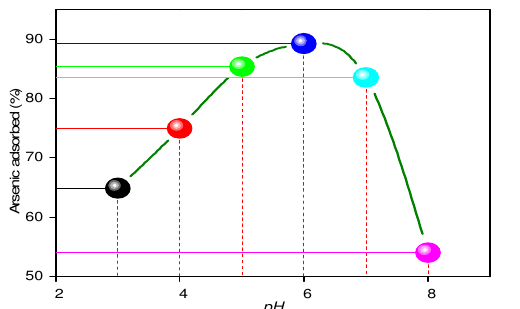
pH Fig. 4: Effect of ph on Shikarap Iron Ore (Sorbent Dose 0.5g Per 50ml, As (III) Concentration 50 mg L -1 , Shaking Time 2h, RPM 150).